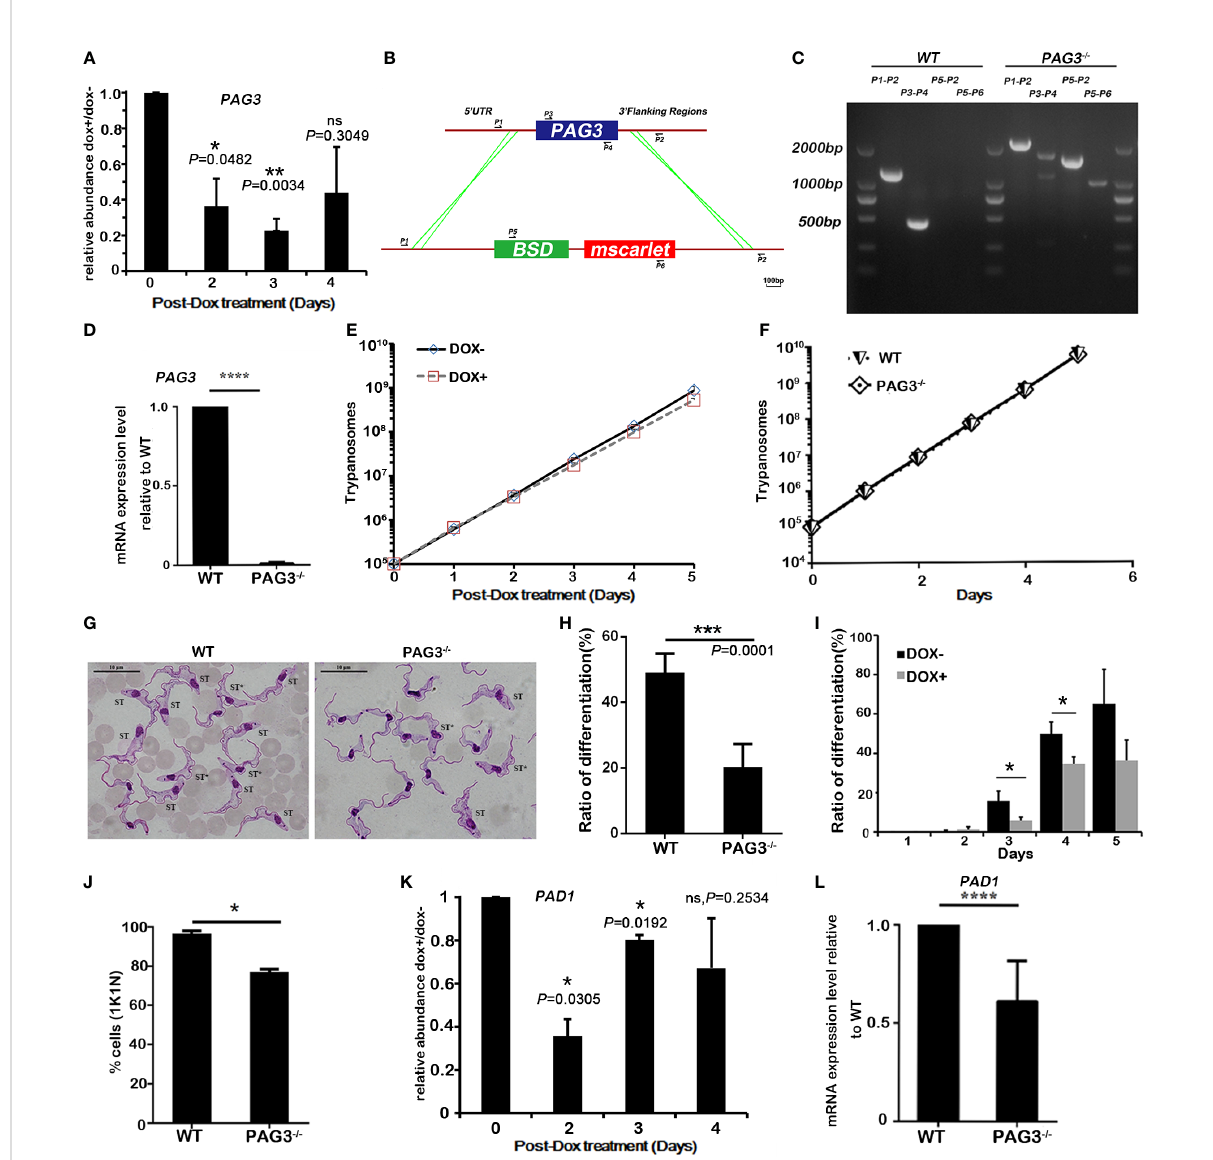
FIGURE 1 Expressionof PAG3 promotes stumpy formdifferentiation in T. brucei . (A) Quantitative real-timePCR analysis ofRNA levels of PAG3 inconditional knockdown cell lines. The relative abundance ofthe induced cells (DOX+)compared tothe non-induced cells (DOX-)was plotted. These values were normalized using the transcripts ofthe housekeeping gene b -tubulin whose levels arenotaffected by RNAi. Error bars represent SD, n=3, 3 experiments. (B, C) . PCR-ampli fi cation system for verifying the CRISPR-Cas9 knockout clone. Primer pairs1 and 2, 3 and 4,3 and 2 wereused to amplify the intact or partial PAG3 coding gene. Primer pair5 and 6 was used for identifying the drug selected gene BSDand fl uorescent protein gene tagging. (D) The quantitative PCRanalysis of RNA expression levels of PAG3 in wild-type celllines and PAG3 deleted celllines. These values have been normalized using the transcripts ofAN1.Error barsrepresent SD(n=3), 3 experiments. (E, F) The growth curves of T.brucei wild-type cells (WT) in vitro , the PAG3 conditional silenced clone (E) and the PAG3 knock-out clone (F) . Cells werediluted to 1×10 5 /ml and the number ofcells weremeasured every 24h. (G) The morphological analysis oftrypanosomes isolated after 5 days post infection (the parasitemia was about 7×10 8 /ml). Wild-type cells became morphologically stumpy with 1K1N ( Left ),while a higher proportionof PAG3 knockout cells remained long andslenderwith 2K1N ( Right ). Nuclear and kinetoplast DNA was visualized by GIEMSA stain (Scalebar, 10µm).ST* indicates intermediate formthat transits fromSL to ST. (H) The proportionof differentiated cells, including intermediate and stumpy forms, inG. (I) The proportionof differentiated cells, including intermediate and stumpy forms, in samples taken fromday 2 to day 5 post infection for the PAG3 RNAiinduced cells (DOX+) or the non-induced cells (DOX-). Error bars represent SD(n=3 mice, about 200-300 trypanosomes for eachgroup). (J) The proportion of1K1Ncells (ameasureof growth arrested stumpy forms) in samples taken fromday 5 post infection for the wild-type and the knock out celllines. Error bars represent SD (n=3 mice, about 200 trypanosomes for each group). (K,L) . The quantitative real-time PCRanalysis of RNA levels of PAD1 in conditional PAG3 knockdown cell lines (DOX+) compared with non-induced cells (DOX-) (K) andwild-type and PAG3 knockout cell lines (L) . These values werenormalized to the transcripts ofthe housekeeping gene b -tubulin (K) or AN1 (L) . Error barsrepresent SD, n=3, 3 experiments. Signi fi cancedifferences between to DOX+and DOX- wereindicated above the bars. Signi fi cances wereaccepted at *P<0.05, **P<0.01,***P<0.001, ****P<0.0001,ns, not signi fi cant, using the Student ’ s t